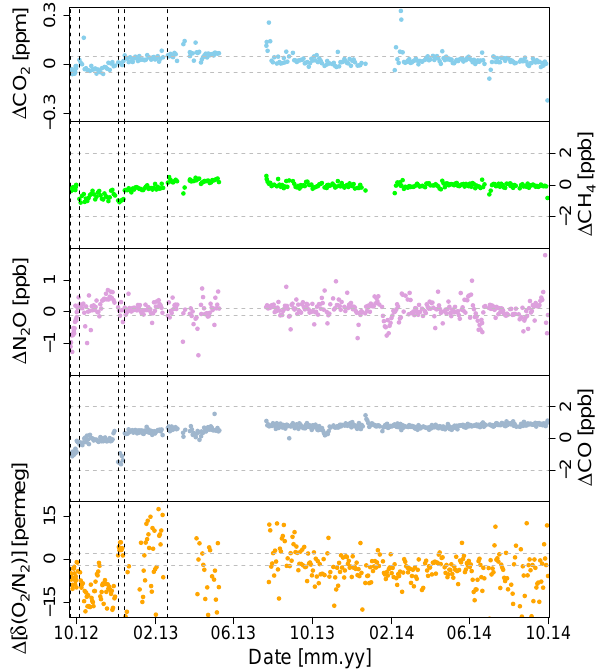
Figure 6. Target measurements for all measurands over the station lifetime, plotted as measured value minus assigned value for each cylinder. The assigned value comes from analysis done at MPI- BGC laboratories. The biases of each tank (differences between the MPI-BGC assigned value and the average NDAO determination) are given in Table 4. The dashed vertical lines indicate a target tank change and the dashed horizontal lines delineate the WMO/GAW measurement compatibility goals.